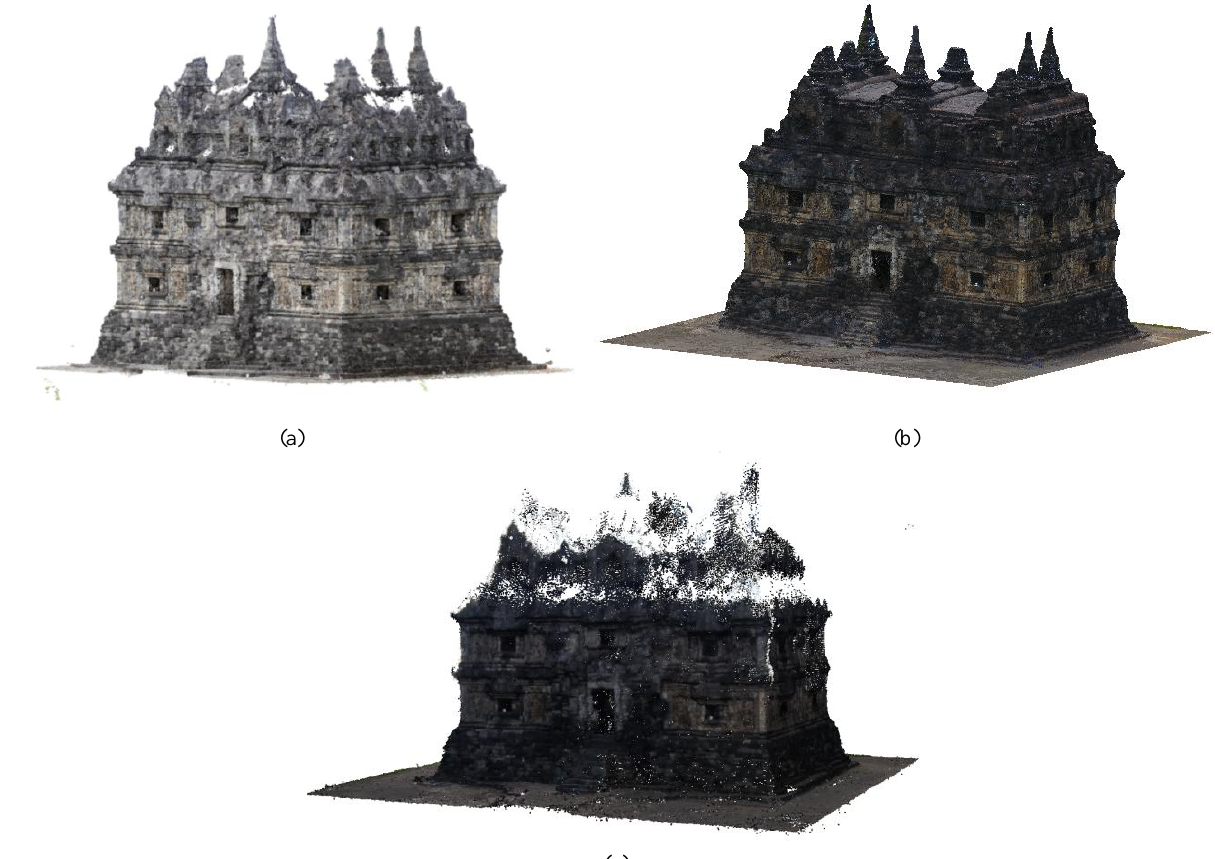
Figure 2. Dense point cloud results from the three tested sensors: (a) DSLR, (b) drone, and (c) 360 0